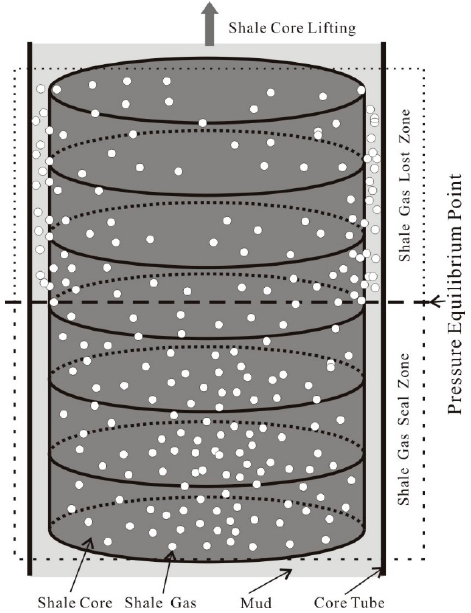
Figure 4. A geological model of the lost shale gas during shale core lifting.